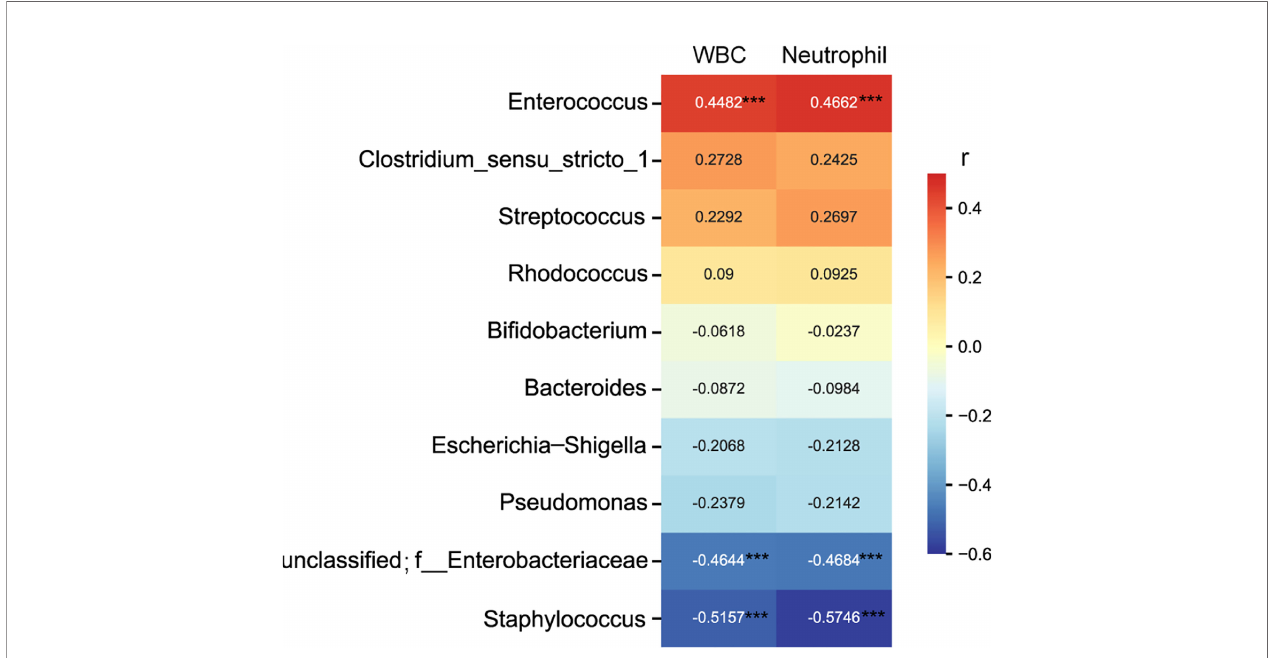
FIGURE 3 | Heatmap of the correlation coef fi cients between the top ten genera and neonatal white blood cell and neutrophil counts. Spearman ’ s correlation coef fi cients are given in the heatmap, and signi fi cant correlations are represented by ‘ *** ’ with FDR corrected P <